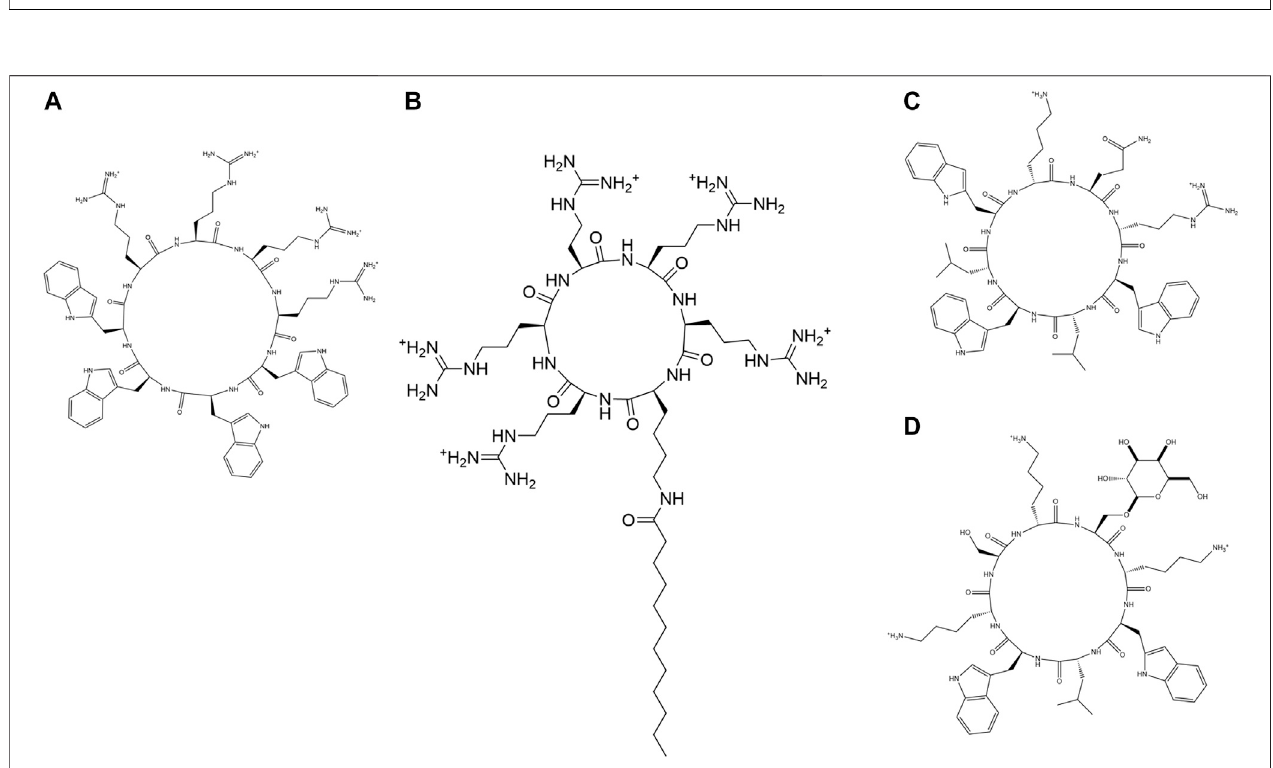
FIGURE 8 | Examples of synthetic cyclic AMPs. (A) (R 4 W 4 ) (Oh et al., 2014). (B) C12-R5 (Oh et al., 2014). (C) (kQrWlWlW) (Fernandez-Lopez et al., 2001). (D) (WlWkUkSk), U (cid:1) Ser( α -Man) (Motiei et al., 2009).